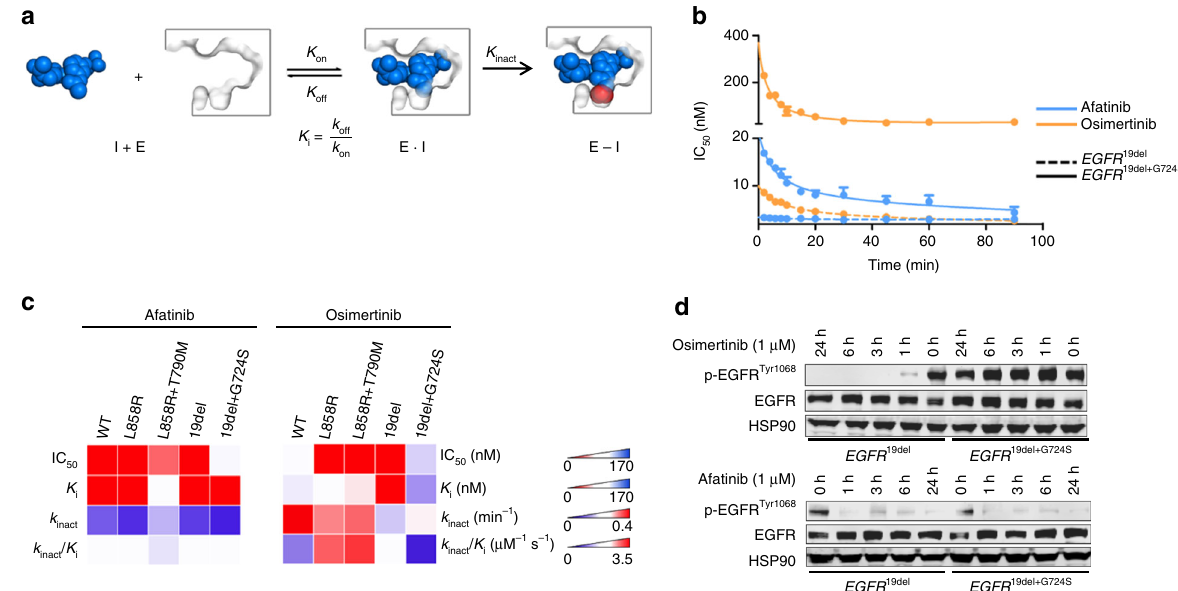
Fig. 5 Kinetic evaluation of second- and third-generation EGFR TKIs against EGFR mutant proteins. a Schematic overview of two-step binding mechanism of covalent inhibitors to kinases with K i (quotient of k off and k on ) describing the reversible binding af fi nity and k inact describing the rate of inactivation. b Time-dependent IC 50 -determination of afatinib and osimertinib on EGFR mutant proteins. Representative curves of single measurements in duplicates are shown. c Heatmap of biochemical IC 50 -, K i -, and k inact determination of second- and third-generation EGFR TKIs against EGFR mutant proteins. Values are the mean of three independent measurements in duplicates. d Immunoblotting results of NIH-3T3 cells (EGFR 19del or EGFR 19del + G724S ) monitoring phospho-EGFR and total EGFR. Cells were treated for indicated times (0, 1, 3, 6, and 24 h) with osimertinib (1 µ M) or afatinib (1 µ M). HSP90 was used as loading control ( n =